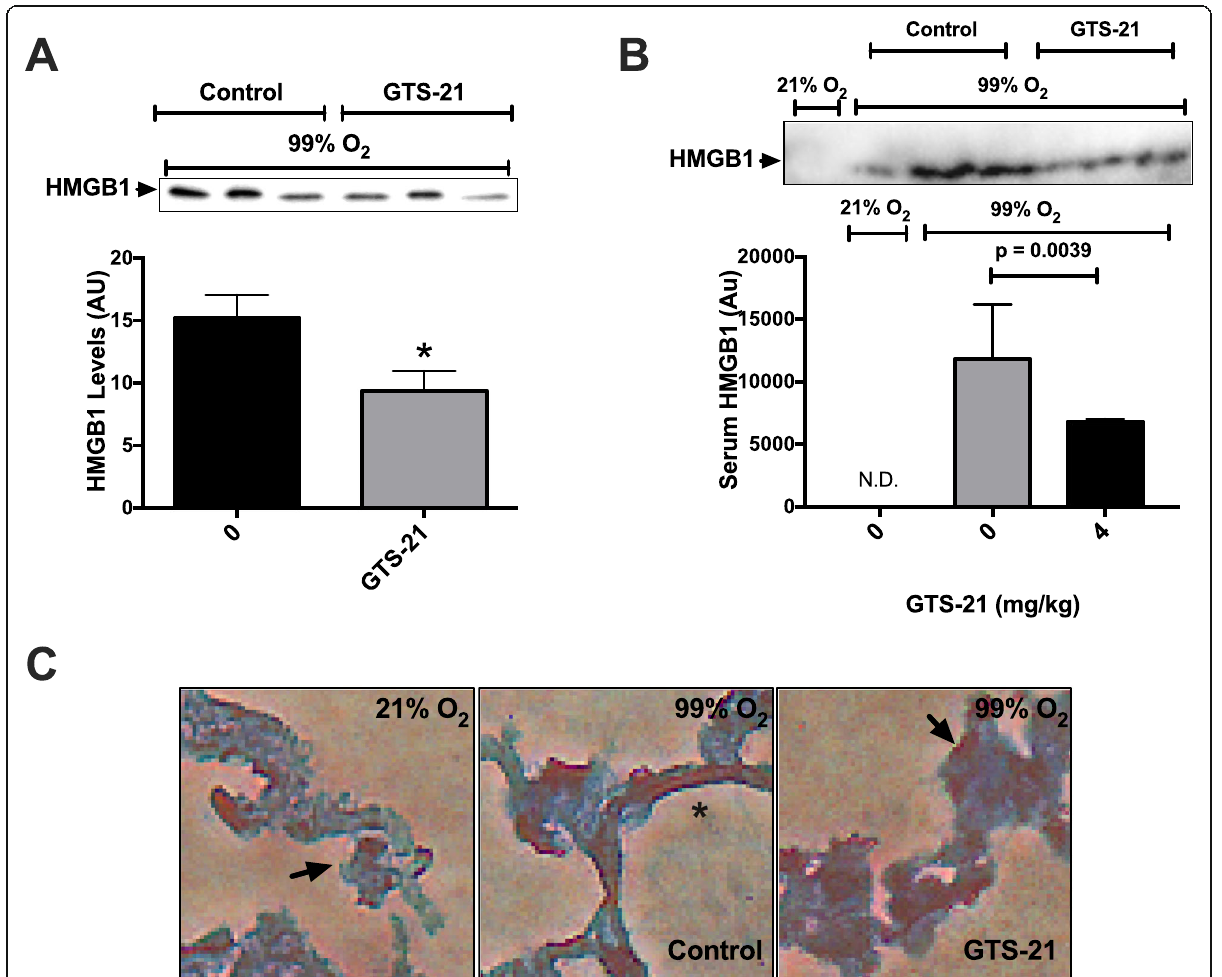
Fig. 2 GTS-21 inhibits hyperoxia-induced translocation and accumulation of HMGB1 in the mouse airways and circulation. C57BL/6 mice were exposed to either 21% O 2 (room air) or to ≥ 99% O 2 and treated with vehicle (0mg/kg) or GTS-21 (4mg/kg), as described in Fig. 1. Bronchoalveolar lavage, whole blood, and lungs were harvested at the end of hyperoxia exposure. a A representative image of Western blots showing immunoreactive bands of HMGB1 in the mouse BAL samples. The bar graph shows the integrated density value of the HMGB1 bands of the BAL of hyperoxic mice, administered with normal saline or GTS-21 ( n =10 mice/group). b A representative Western blot for HMGB1 in mouse serum and the integrated density values for each group (N.D., not detected) ( n =3 mice/group). c Representative immunohistochemical staining for HMGB1 in mouse lungs (arrows indicate HMGB1 in nucleus, asterisks represent HMGB1 present in cytoplasm) ( n =3 mice/group). * p <0.05, compared with mice receiving normal